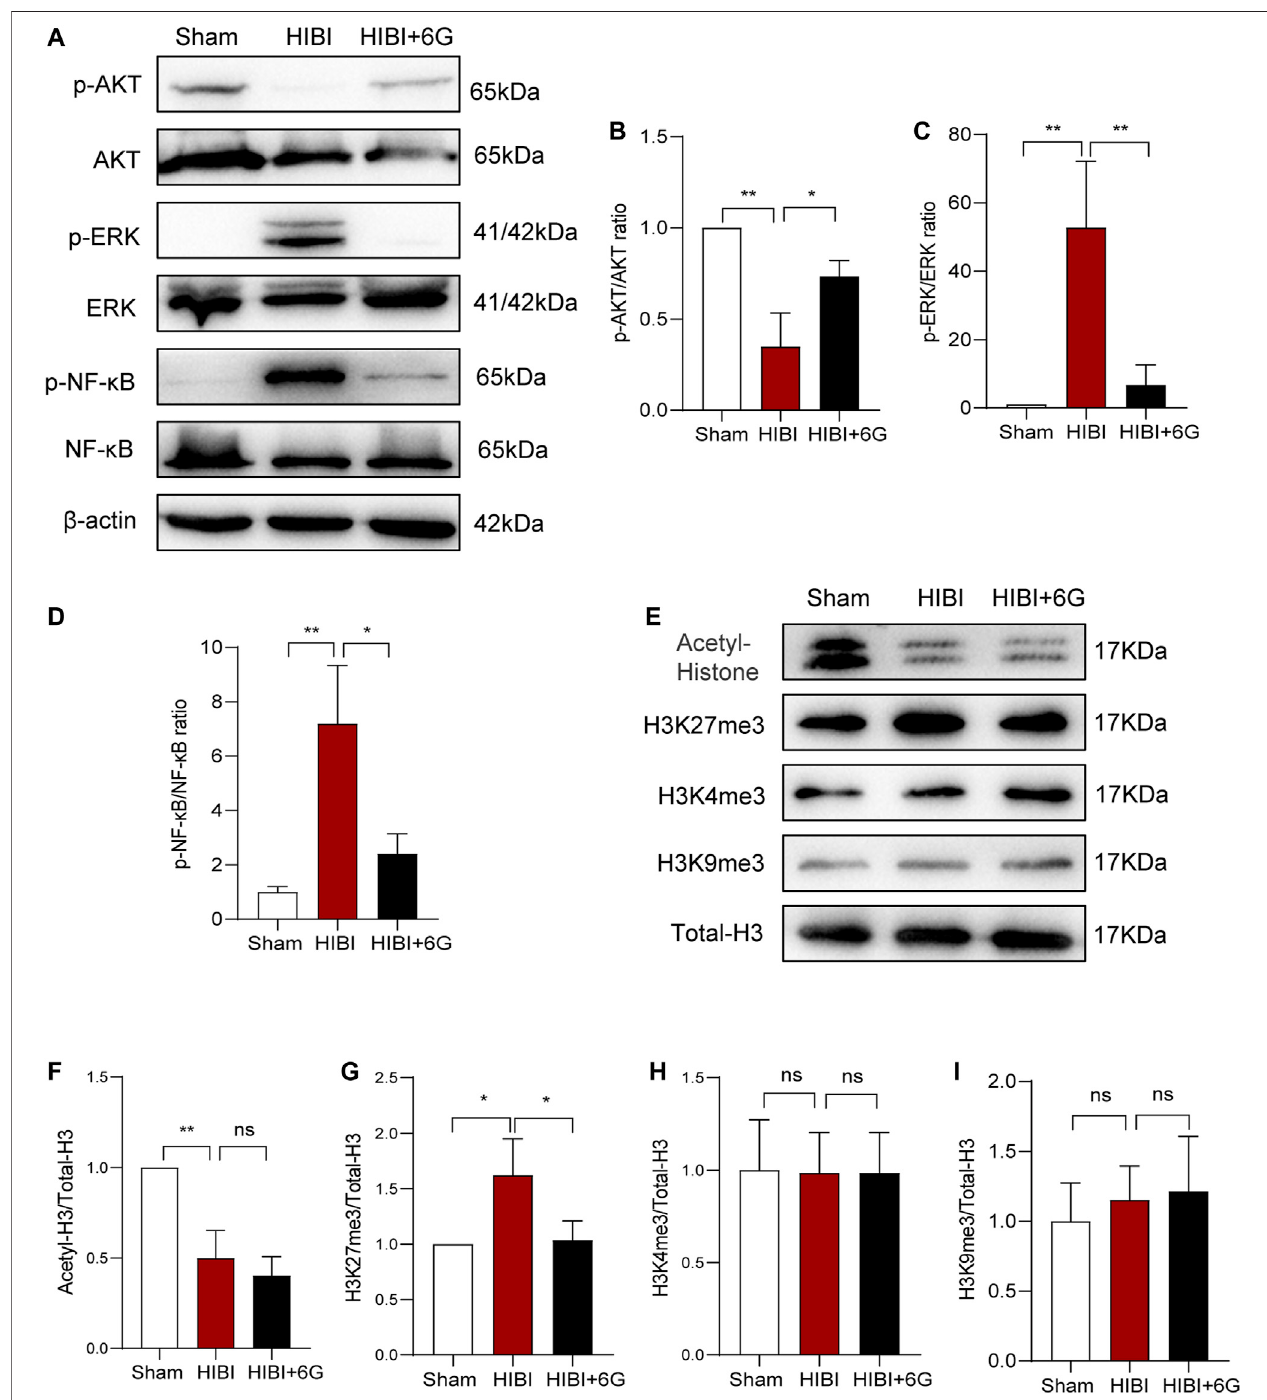
FIGURE 7 | Protein levels related to the AKT, ERK, and NF- κ B pathways, and histone acetylation and methylation. (A – D) Representative western blot images and quanti fi cation of p -AKT, p -ERK, p-NF- κ B expression in the brain. (E – L) Representative western blot images and quanti fi cation of histone acetylation and methylation expression in the brain. n (cid:1) 3 per group. Data represent the mean ± SEM. * p < 0.05, ** p < 0.01, *** p < 0.001, **** p < 0.0001.